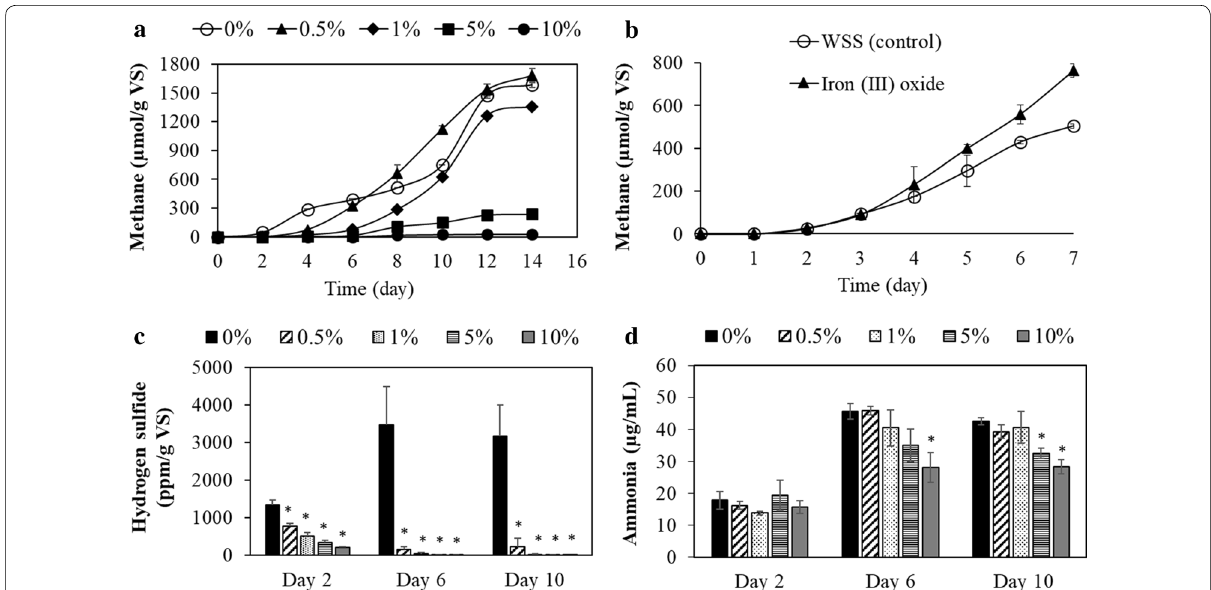
Fig. 1 Impact of Aso limonite on the production of gases (methane and hydrogen sulfide) and ammonia in anaerobic digestion processes using waste sewage sludge (WSS); a methane production in different percentage of Aso limonite, b methane production in the WSS with iron (III) oxide at 5% (w/v), c hydrogen sulfide and d ammonia were measured at day 2, 6, and 10 of incubation in different percentage of Aso limonite. The legend denotes the concentration of Aso limonite as % (w/v). Error bars represent the standard errors (n by the addition of Aso